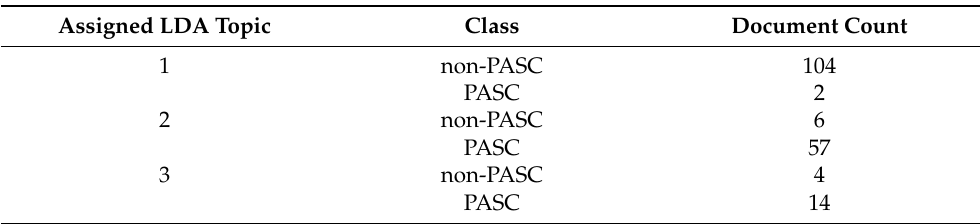
Table 2. Distribution of LDA topics wrt the considered classes. Assigned LDA Topic